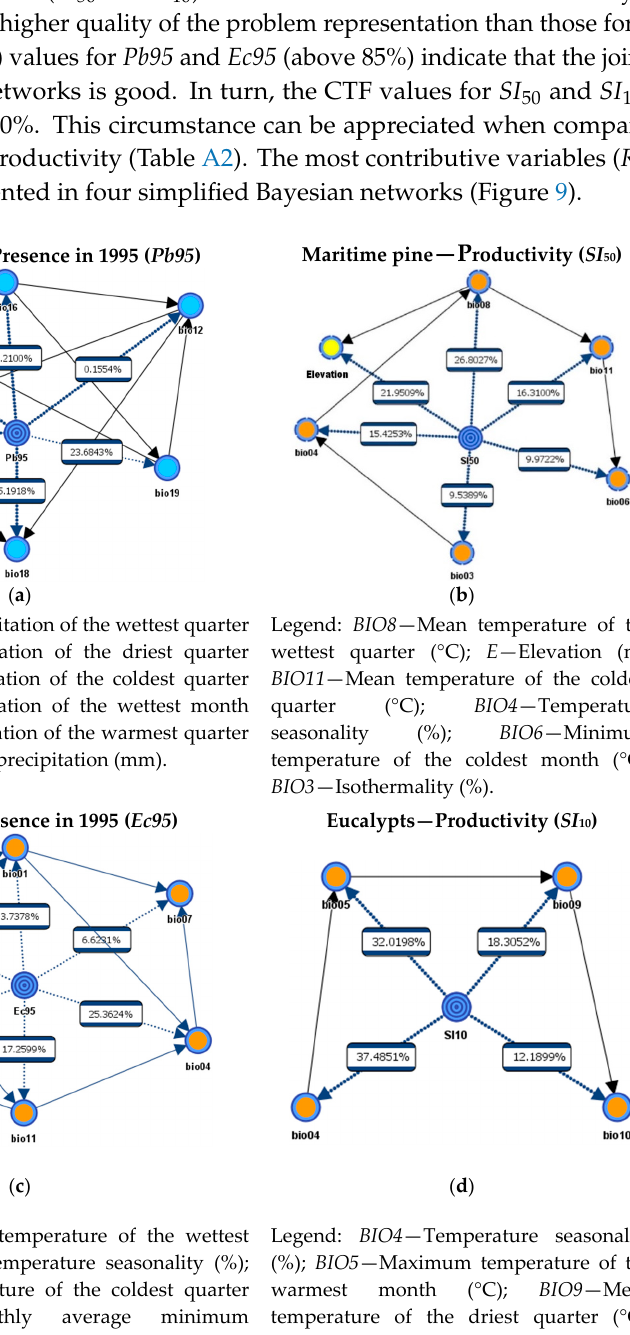
Figure 9. Bayesian networks analysis—Variable contribution to the target node (%): ( a ) Maritime pine presence in 1995 ( Pb95 ); ( b ) Maritime pine productivity in 1990–1994 ( SI 50 ); ( c ) Eucalypts presence in 1995 ( Ec95 ); ( d ) Eucalypts productivity in 1990–1994 ( SI 10 ).